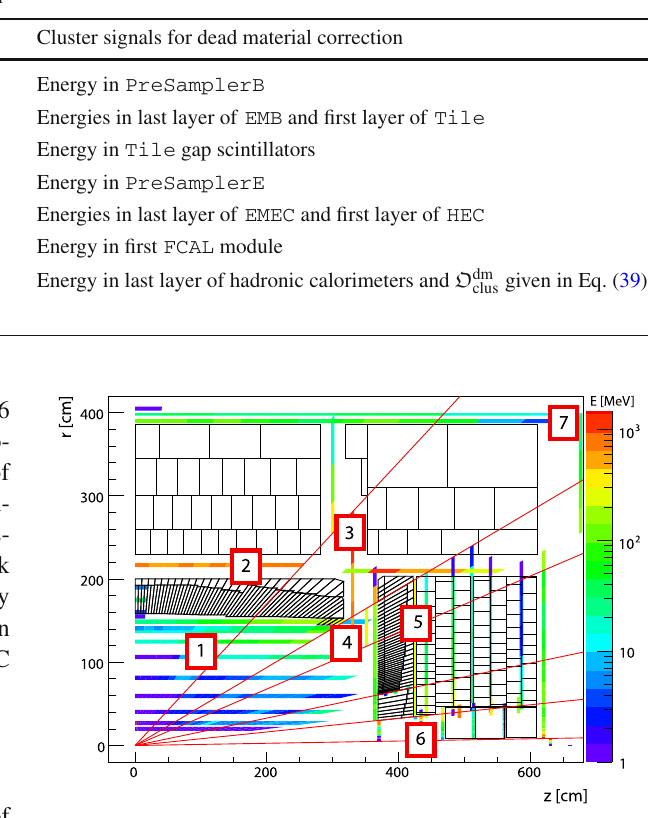
prises all dead material volumes with energy loss outside regions 1–7. These are mostly small volumes located between and behind the active